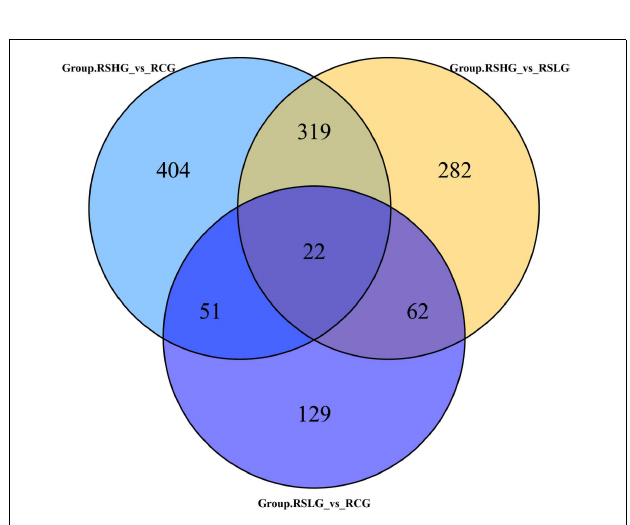
FIGURE 5 | Venn diagram of